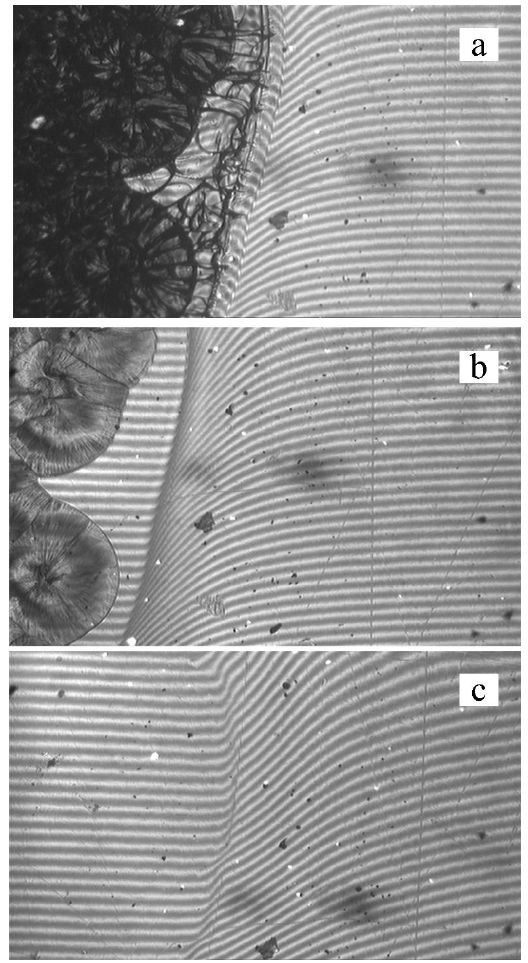
Figure 3. Interference patterns of the interdiffusion zones of the ACP – DER-331 system obtained at ( a ) b ) 180 and ( c ) 270 ◦ 20, ( b ) 180 and ( c ) 270 °C. 20, (